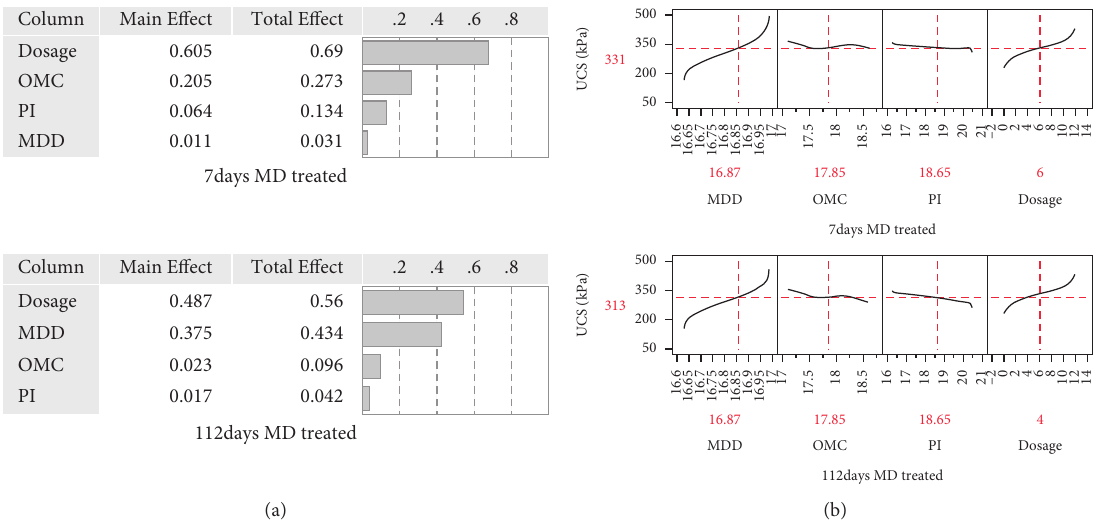
Figure 10: ANN-based sensitivity analyses: (a) variable order and magnitude of influence and (b) variable impact profiler for MD-treated samples.